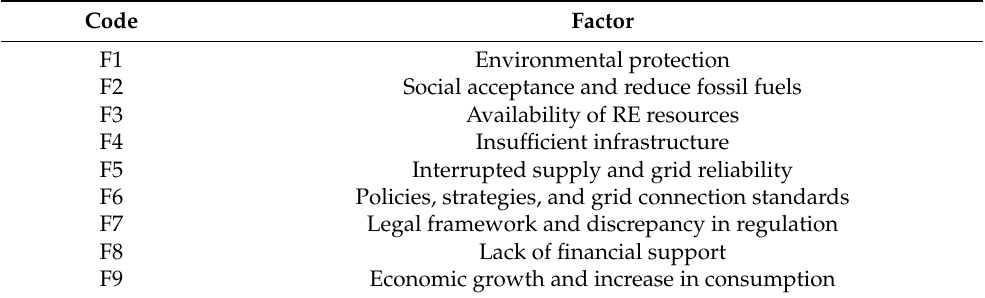
Table 3. Validated Factors That Affect UAE’s Renewable